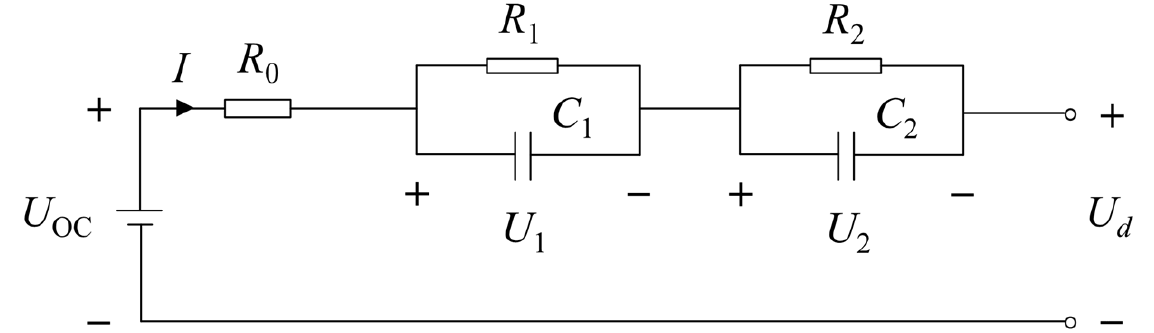
Figure 1. The second-order RC equivalent circuit Figure 1. the second-order RC equivalent circuit model.